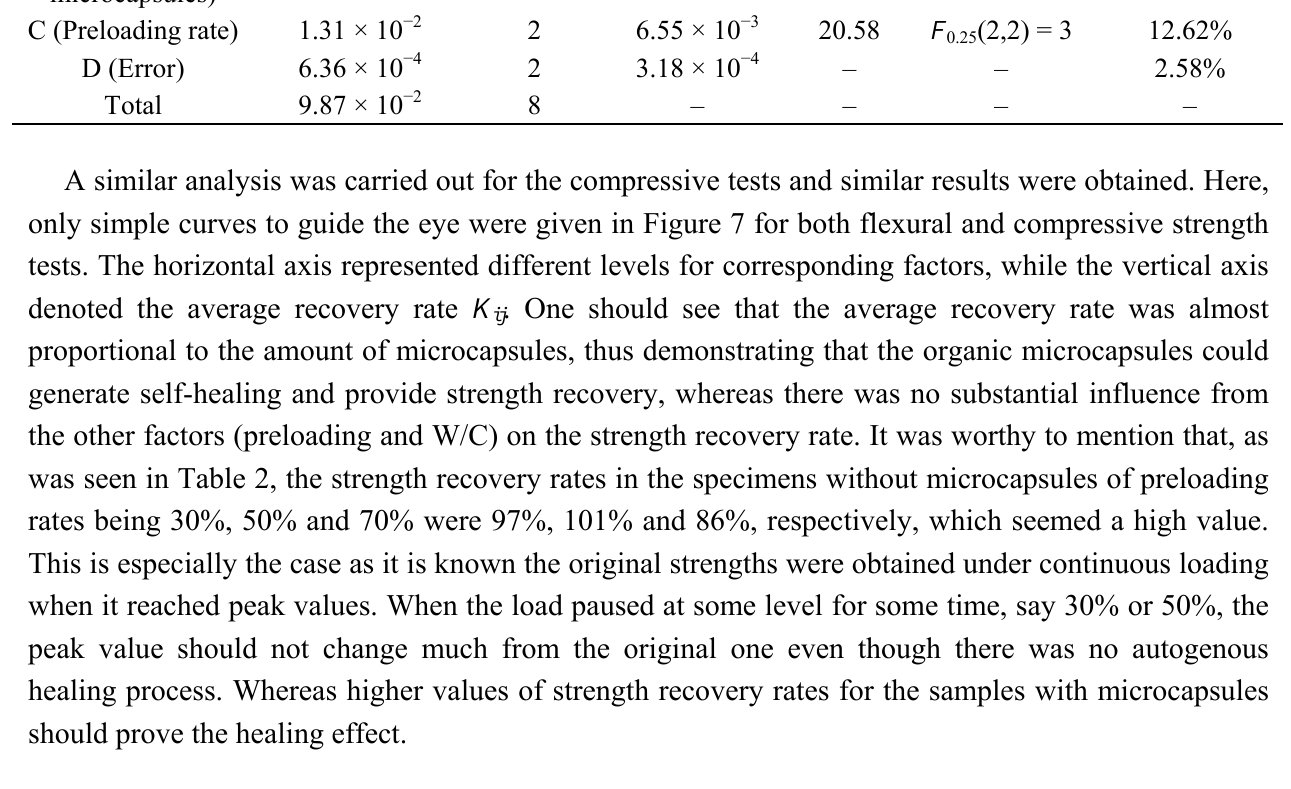
Figure 7. Relationship between the factors and strength recovery